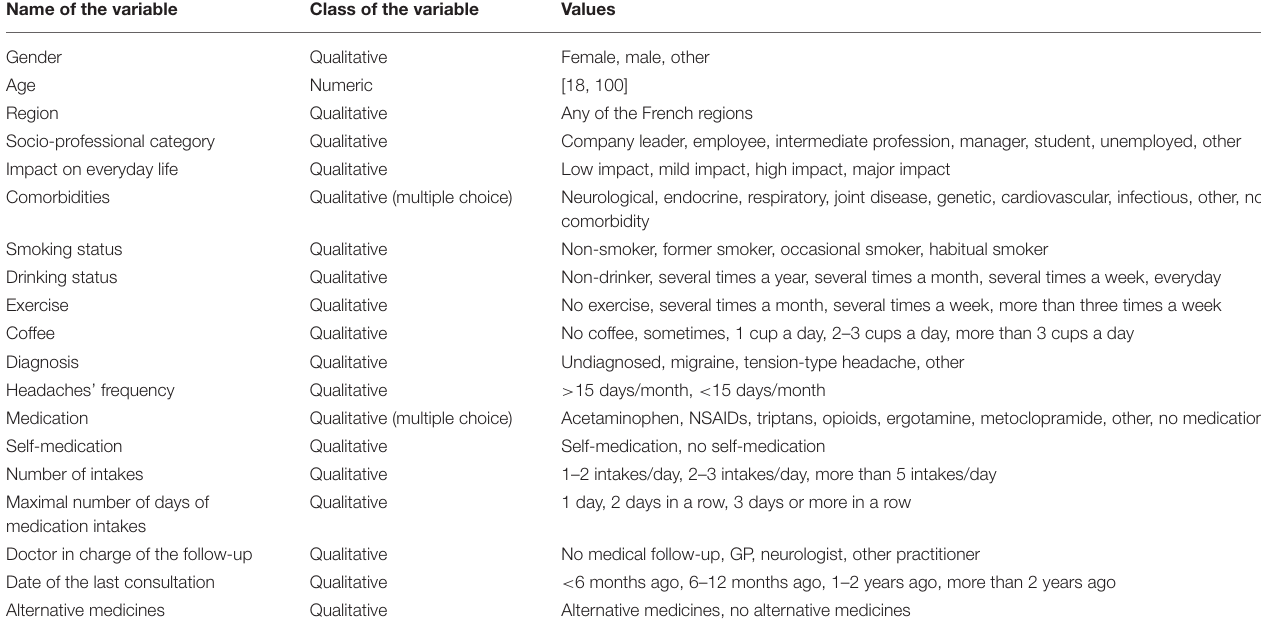
TABLE 2 | List of variables.